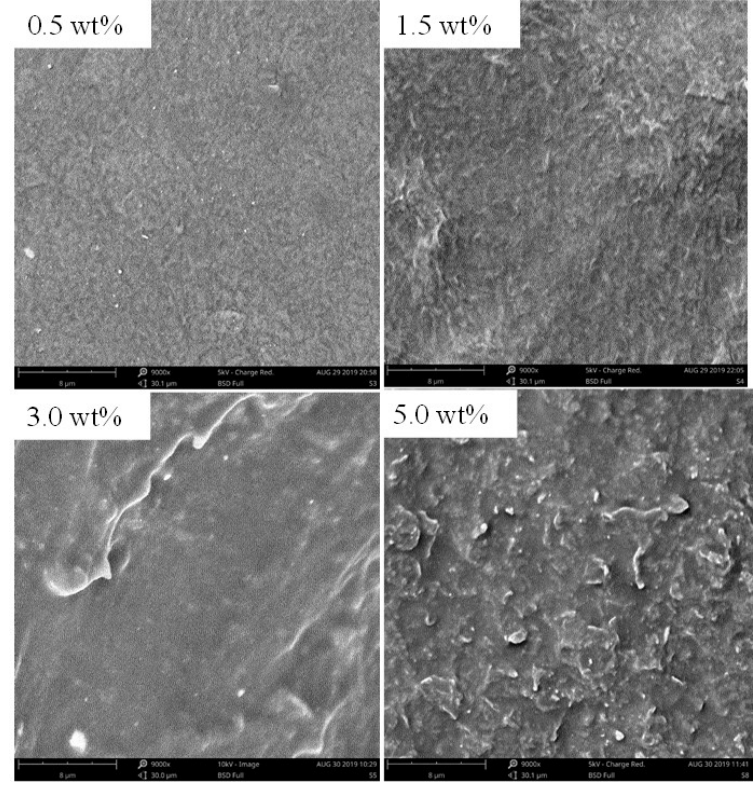
Figure 2. SEM images of surface morphology of the composite films with di ff erent mass contents of graphene.